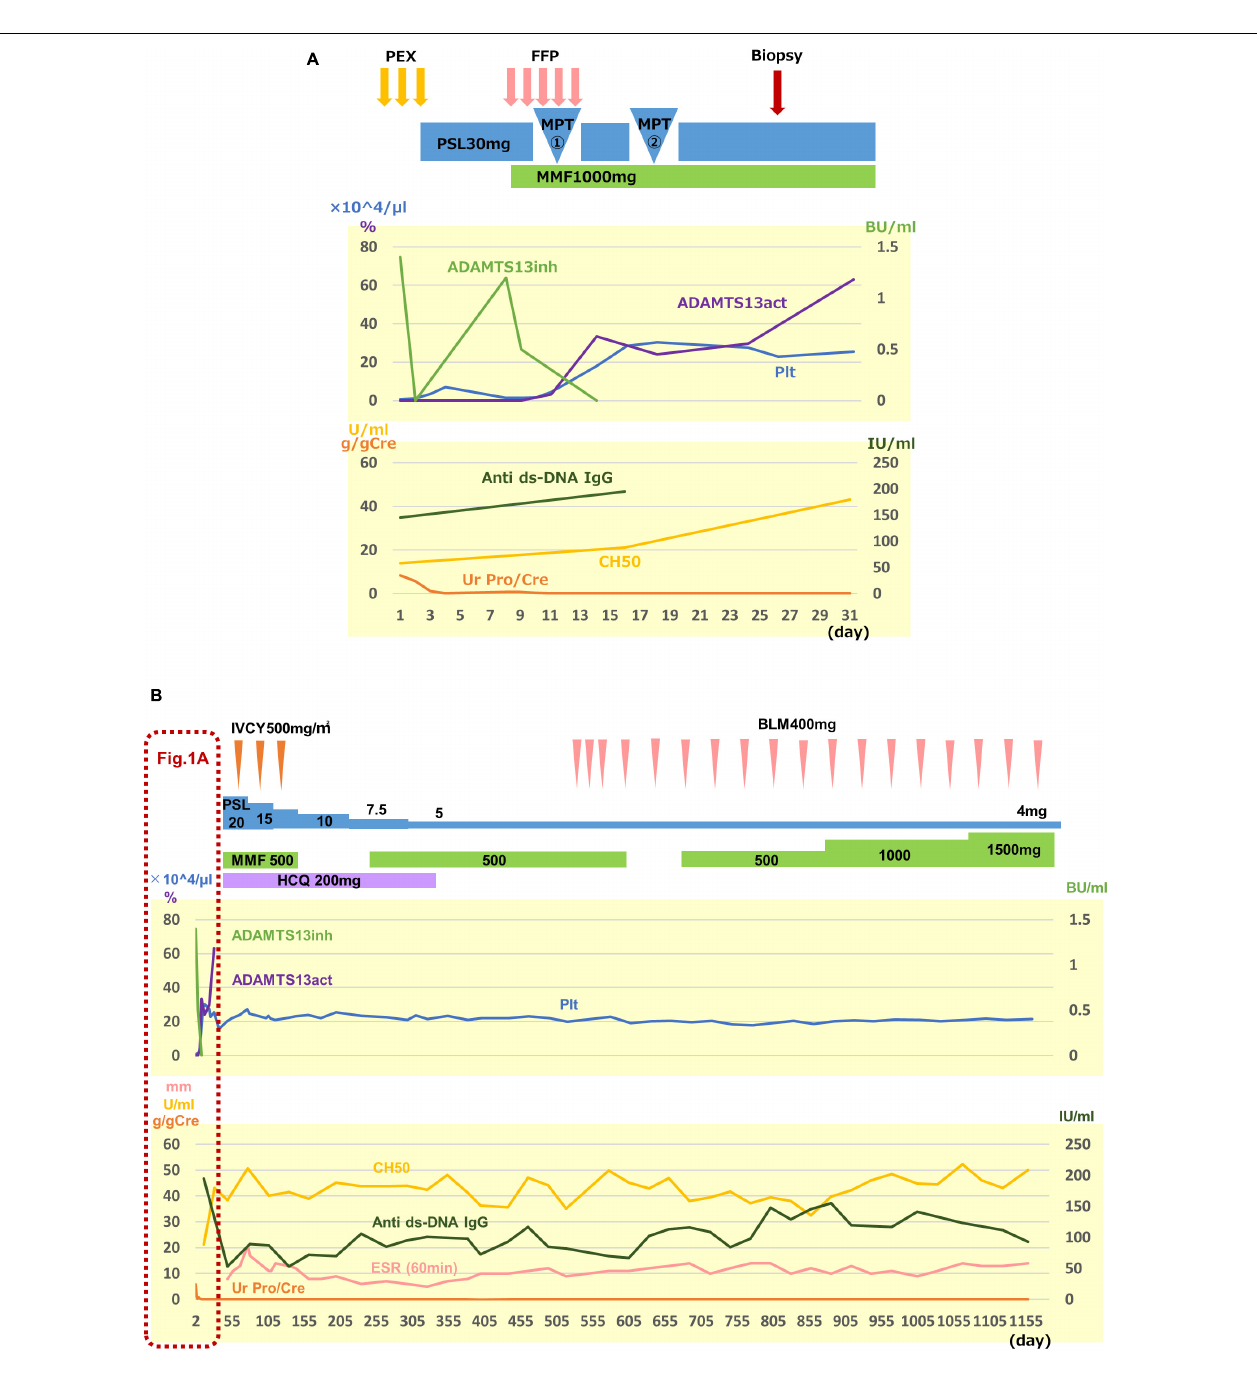
FIGURE 1 | Clinical course. The upper graph shows the activity of TTP, and the lower graph shows the disease activity of SLE and lupus nephritis, both in (A,B) . (A) Clinical course for the first 31 days after admission is shown. Three courses of plasma exchange (PE) were effective to remove anti-ADMTS13 antibody (ADMTS13inh) and to increase a platelet count (Plt) rapidly. However, 30 mg of prednisolone (PSL) injection and fresh-frozen plasma (FFP) infusion were not sufficient to suppress antibody production to recover ADAMTS13 activity (ADAMTS13act) and to maintain the platelet count. After two courses of methylprednisolone pulse therapy (MPT), the recovery of the ADAMTS13 activity and the platelet count was observed. Proteinuria disappeared after the first course of pulse therapy. Renal biopsy was performed on the 25th hospital day. (B) Overall clinical course is shown. Treatment details and clinical data are shown following (A) . Since the patient was considered to be in the high-risk group of SLE organ damage, and TMA is known to have frequent complications of psychiatric symptoms, she was additionally treated with three courses of intravenous cyclophosphamide pulse therapy (IVCY) as induction therapy for SLE, in addition to mycophenolate mofetil (MMF) and hydroxychloroquine (HCQ). HCQ was discontinued because color blindness and retinopathy were suspected at a regular ophthalmologic visit, and belimumab (BLM) was started instead just after BLM had become under health insurance coverage for SLE pediatric patients (B) . Ur Pro/Cre, urinary protein creatinin ratio; anti ds-DNA IgG, anti-double-stranded DNA immunogloburin G; ESR, erythrocyte sedimentation